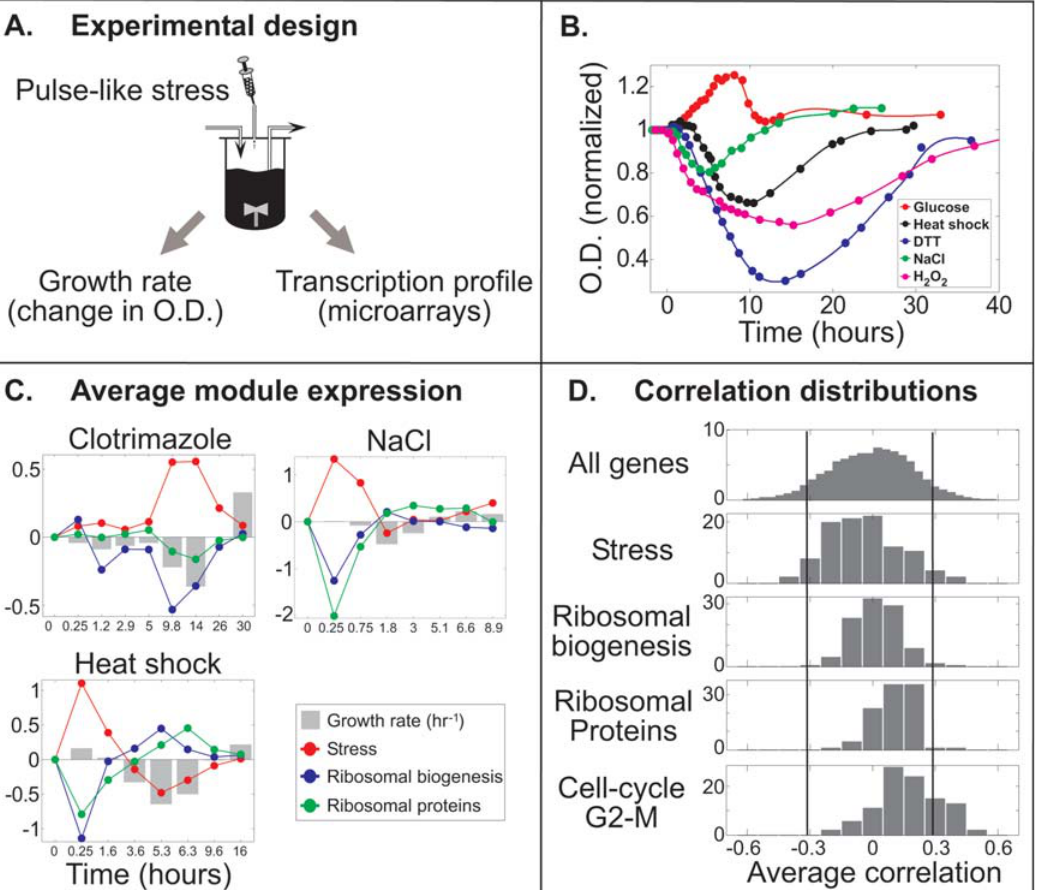
Figure 3. Gene expression versus growth rates in continuous cultures. (a) Steady state growing cells were subjected to different environmental stresses. Growth rate was calculated from the measured optical density. Simultaneously, the profile of gene expression was quantified with microarrays. In our study we looked for possible correlations between growth and gene expression (see Methods for more details). (b) Cells grown at steady state in a glucose-limited chemostat were subjected to 5 different environmental cues. We examined 4 stress pulses: H 2 O 2 (0.6mM-magenta curve), DTT (6mM-blue curve), NaCl (0.4M-green curve), heat shock (39 u C for 5 hours-black curve), and a stress-relieving pulse of glucose (0.2 g/l-red curve). The Y-axis is normalized such that the steady state O.D. (at t , 0) is 1. The markers designate O.D. sampling time, and solid lines are spline interpolations of the data. The perturbations in histidine-limited chemostat are shown in figure S2. (c) Dynamics of the average log 2 -ratio-expression for three ESR gene modules. The DTT, NaCl and heat shock pulses were given during glucose depletion, and the clotrimazole perturbation was given in histidine limitation. Bars designate the cells growth rate, which is normalized relative to the steady state growth rate (see Fig. S3 for other perturbations dynamics). (d) Each gene was assigned a growth correlation score (GCR), quantifying the correlation between its expression level and growth rate, averaged over all perturbations (Methods). The GCR distribution of several gene modules is shown. The X-axis represents the calculated average correlation, and Y-axis represents the fraction of genes within the module. The two vertical lines designate the threshold for the 5% of genes with the highest or lowest GCR. Notably, the distribution for the ribosomal biogenesis genes lies between the thresholds, while the cell-cycle G2-M gene group is enriched with positive GCR